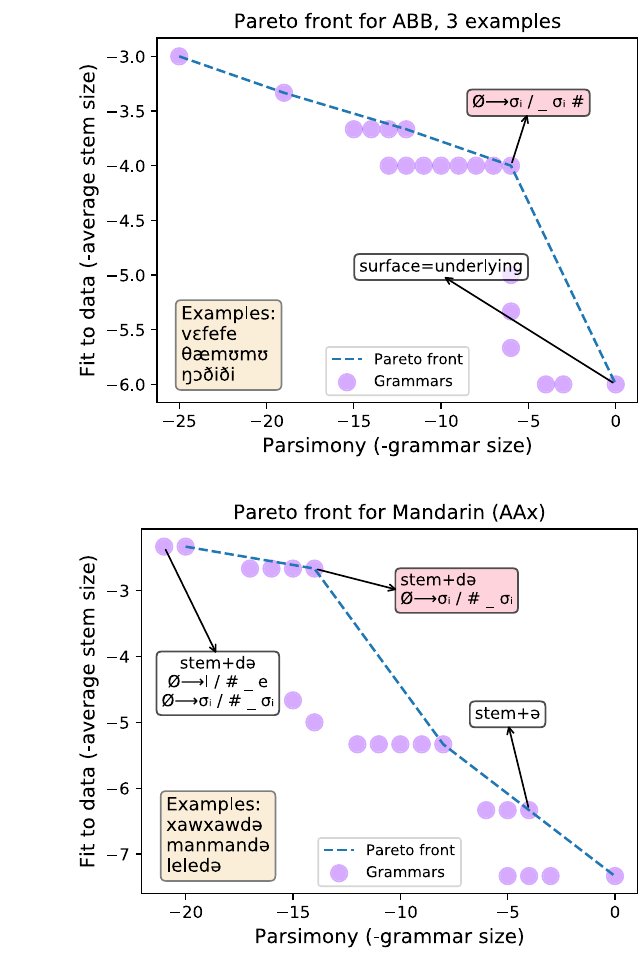
Fig. 7 | Modeling ambiguity in language learning. Few-shot learning of language patternscanbehighlyambiguousastothe correctgrammar.Herewevisualizethe geometry of generalization for several natural and arti fi cial grammar learning problems. These visualizations are Pareto frontiers: the set of solutions consistent with the data that optimally trade-off between parsimony and fi t to data. We show Pareto fronts for ABB (ref. 39; top two) & AAX (Gerken 53 ; bottom right, data drawn from isomorphic phenomena in Mandarin) AGL problems for either one example word (upper left) or three example words (right column). In the bottom left we show the Pareto frontier for a textbook Polish morpho-phonology problem. Rightward on x -axis corresponds to more parsimonious grammars (smaller rule size + af fi x size) and upward on y-axis corresponds to grammars that best fi t the data (smaller stem size), so the best grammars live in the upper right corners of thesegraphs.N.B.:Becausethegrammarsandlexicavaryinsizeacrosspanels,the x